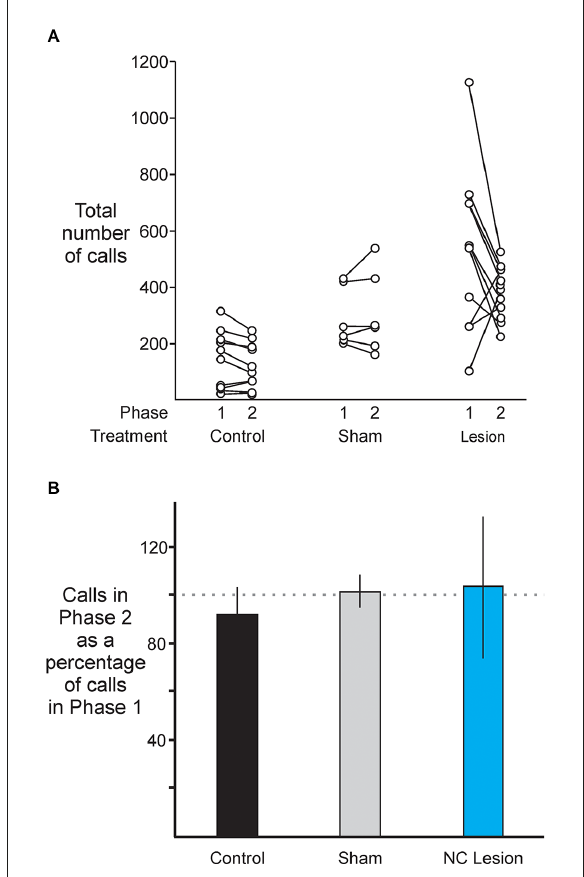
FIGURE3 NC lesioned females were unchanged in their ability to indicate mate preference. (A) Females typically responded to song stimuli by producing large numbers of calls, and the numbers of calls produced varied across birds (individual data points connected by a line indicate the responses of an individual female in Phase 1 and Phase 2). (B) Experimental birds (blue bar, right; N = 11) expressed no significant change in their number of calls performed in Phase 2 as a percent of calls performed in Phase 1 of behavioral testing (bars and lines indicate means and SE; pairedt-test, t =0.50; p =0.62).NochangebetweenPhase1and Phase 2 in the number of calls produced in response to all song stimuli was also evident for control (black bar, left; paired t-test, t = 1.01, p = 0.33, N = 10 birds) and sham conditions (gray bar, middle; paired t-test, t = 0.20, p = 0.85, N = 6